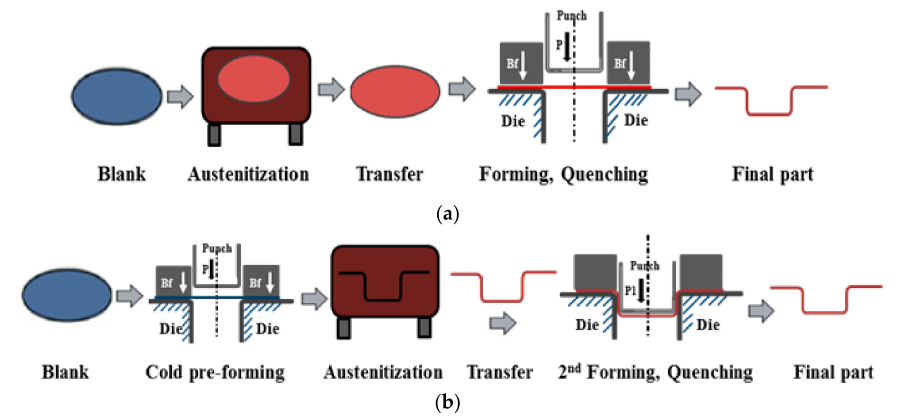
Figure 3. Procedure of hot press forming and cold press forming: ( a ) direct hot press forming (hot deep drawing process); ( b ) indirect hot press forming (cold deep drawing